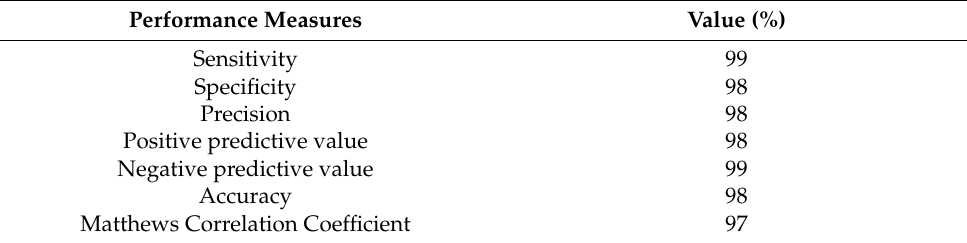
Table 2. Performance of the PD Change